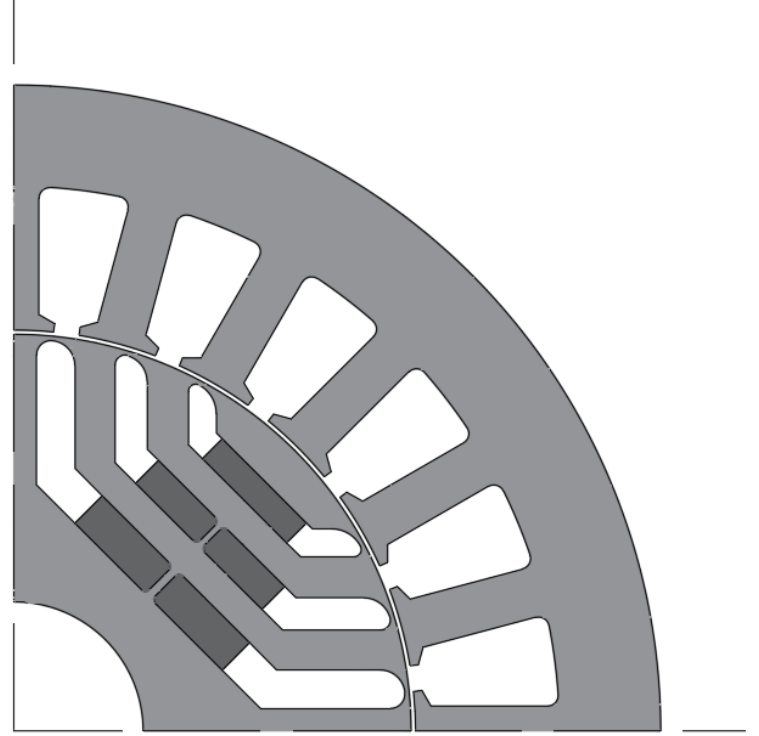
Figure 2. Geometry of the reference IPM synchronous